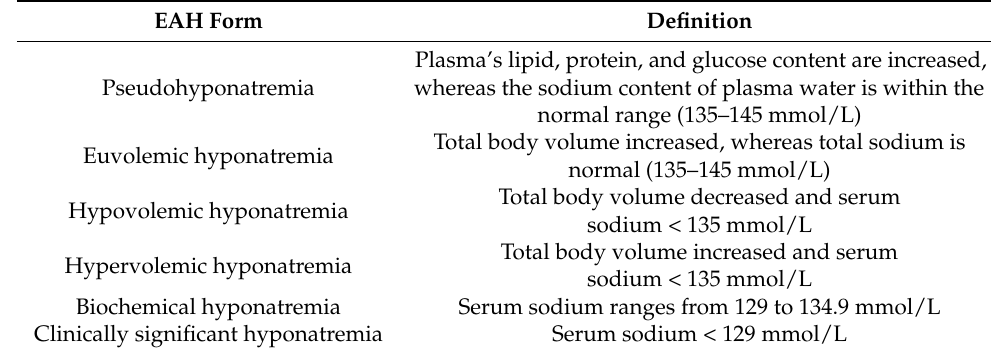
Table 1. Definitions of different forms of hyponatremia